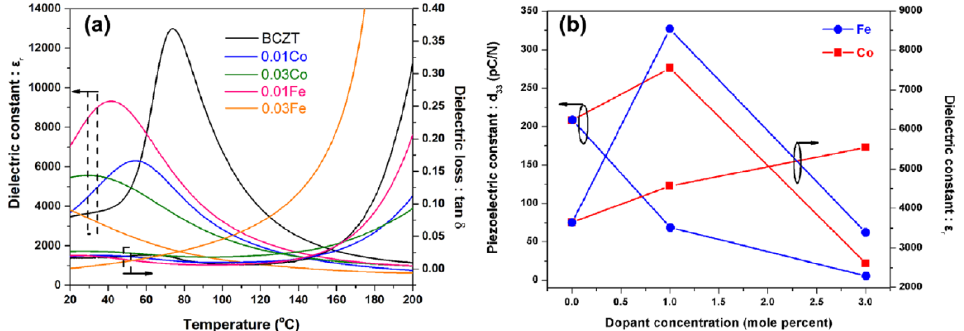
Figure 9. Dielectric and piezoelectric properties of BCZT-xCo and BCZT-xFe ceramics. Dielectric versus temperature at 1 kHz ( a ) and piezoelectric constant as a function of dopant concentration ( b ). Reprinted with permission from [71]. Copyright 2018 WILEY-VCH Verlag GmbH & Co.